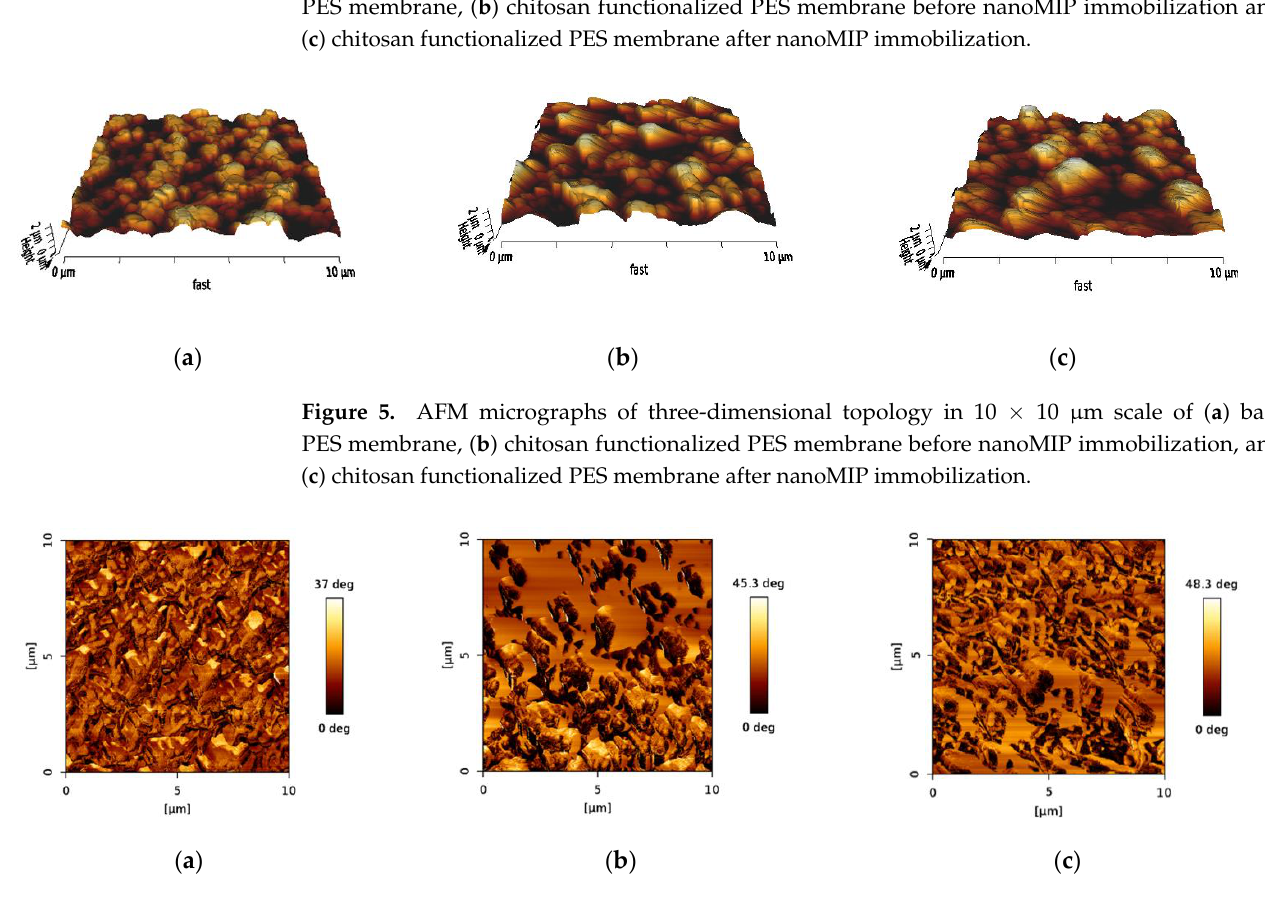
Figure 6. AFM phase images of ( a ) bare PES membrane, ( b ) chitosan functionalized PES membrane before nanoMIP immobilization, and ( c ) chitosan functionalized PES membrane after nanoMIP immobilization.